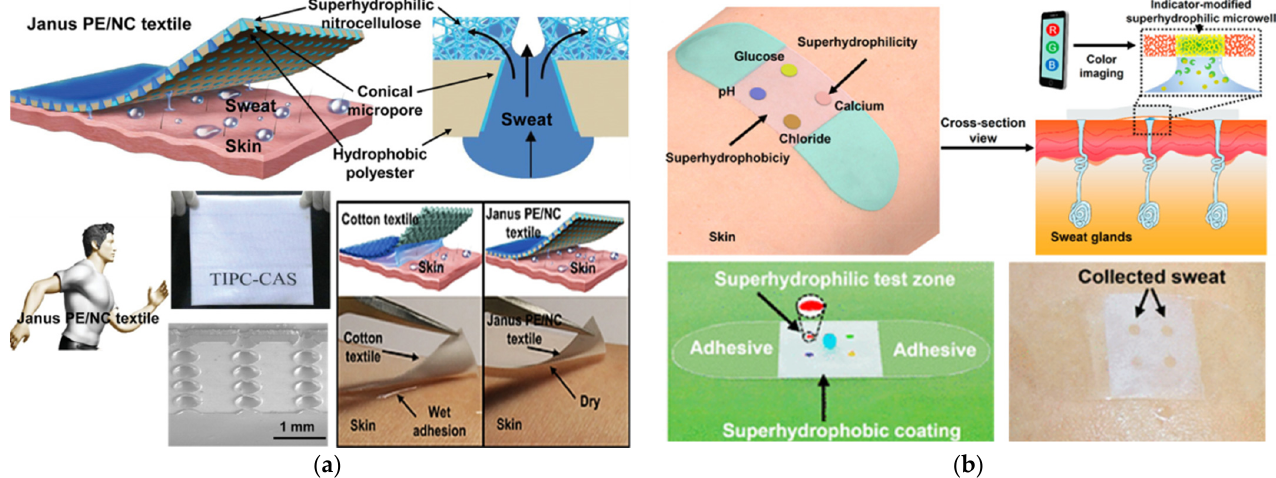
Figure 19. ( a ) Super-hydrophobic/super-hydrophilic surface used for sweat sampling in wearable sensors: Janus PE/NC fabric with conical micropores to transport sweat [54] (Reprinted with permission from ref. [54]. Copyright 2021 John Wiley and Sons); ( b ) a super-wettable band for sweat sampling and multiplex targets analysis [55].